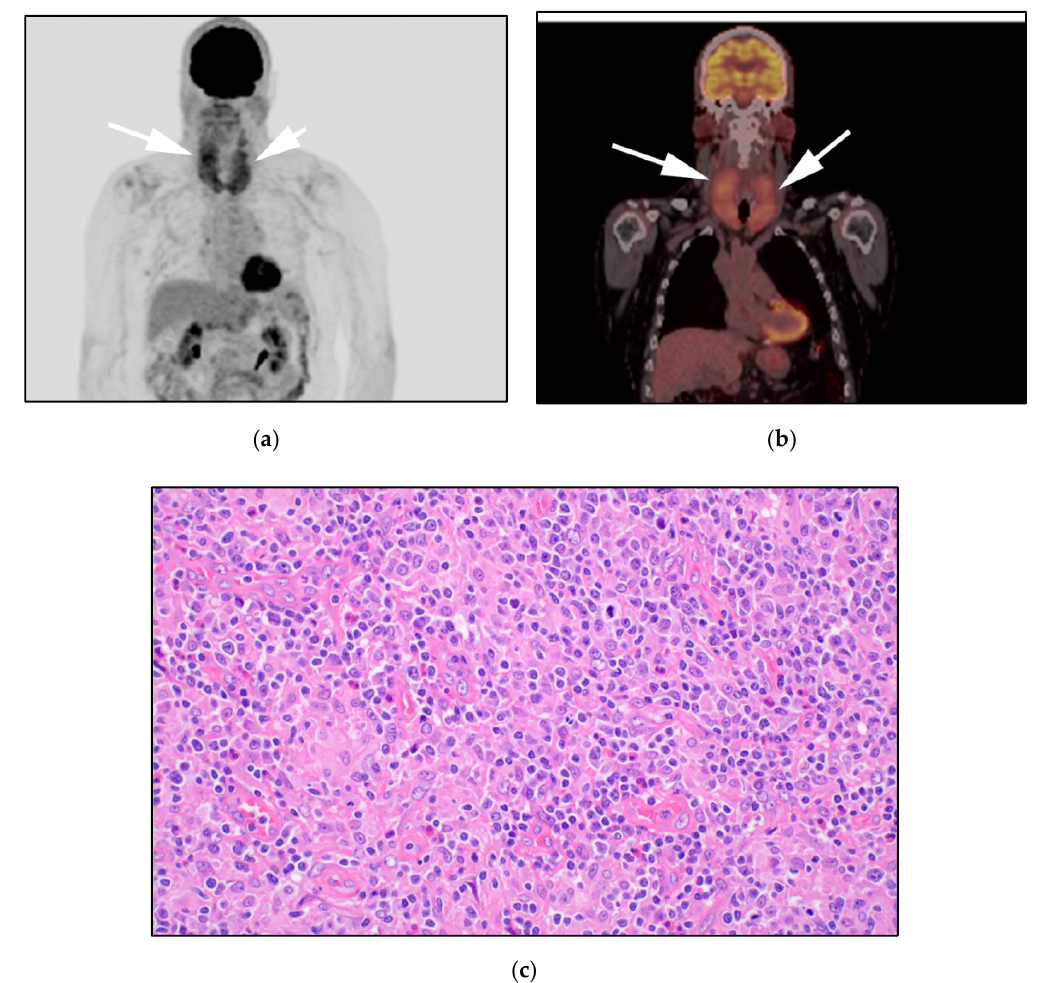
Figure 7. 71-year-old-man with known diagnosis of PTCL-NOS. ( a ) F-18 FDG PET/CT maximal intensity projection (MIP) image demonstrates diffuse hypermetabolic butterfly activity within the mid neck (white arrows). ( b ) FDG PET/CT axial images confirm activity localized to diffusely hypermetabolic enlarged thyroid glands (white arrows). Note no suspicious marrow lesions seen. Marrow biopsy of this patient showed T-cell infiltration, despite negative marrow involvement on PET/CT (which has high rate of false negativity for marrow infiltration). ( c ) Histologic section shows, that cells are atypical medium-to-large-sized cell infiltrates that efface the lymph node normal architecture. A variable number of eosinophils are noted. There is also a prominent epithelioid histiocytic component. (Original magnification 400 × , H&E